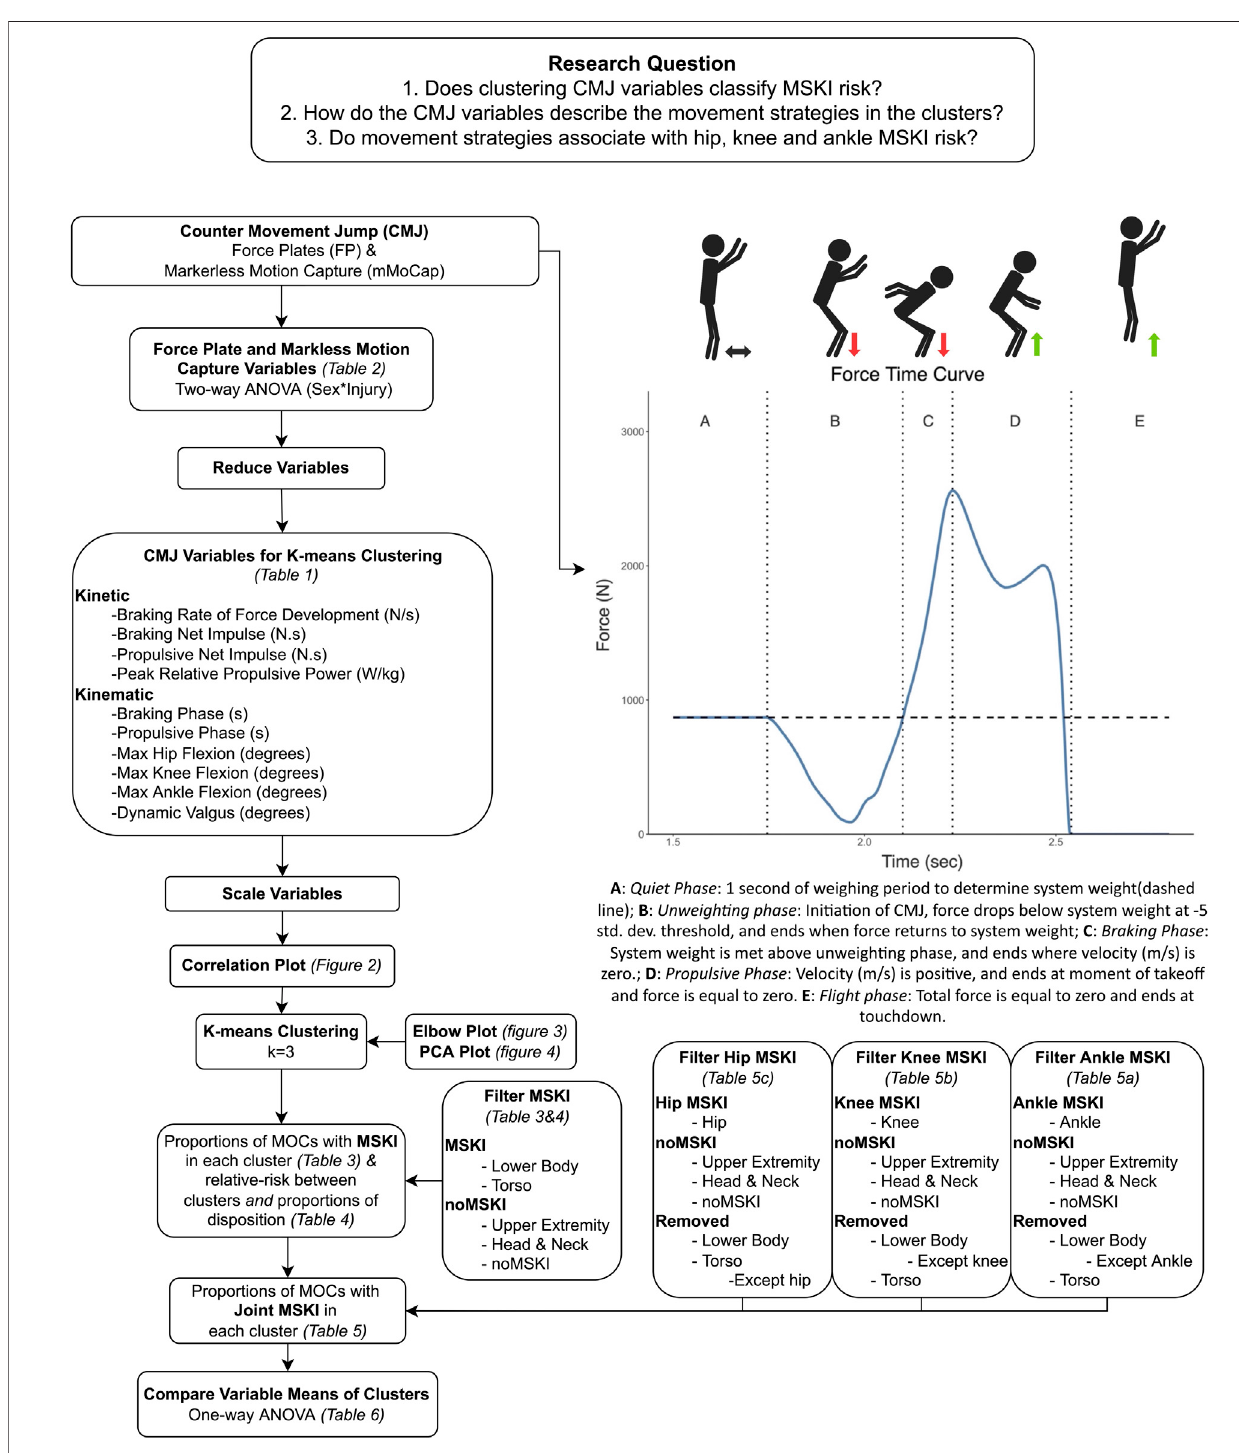
FIGURE 1 | Analytical pipeline describing the data analysis methods, and the force plate force-time curve describing the different phases of the CMJ.